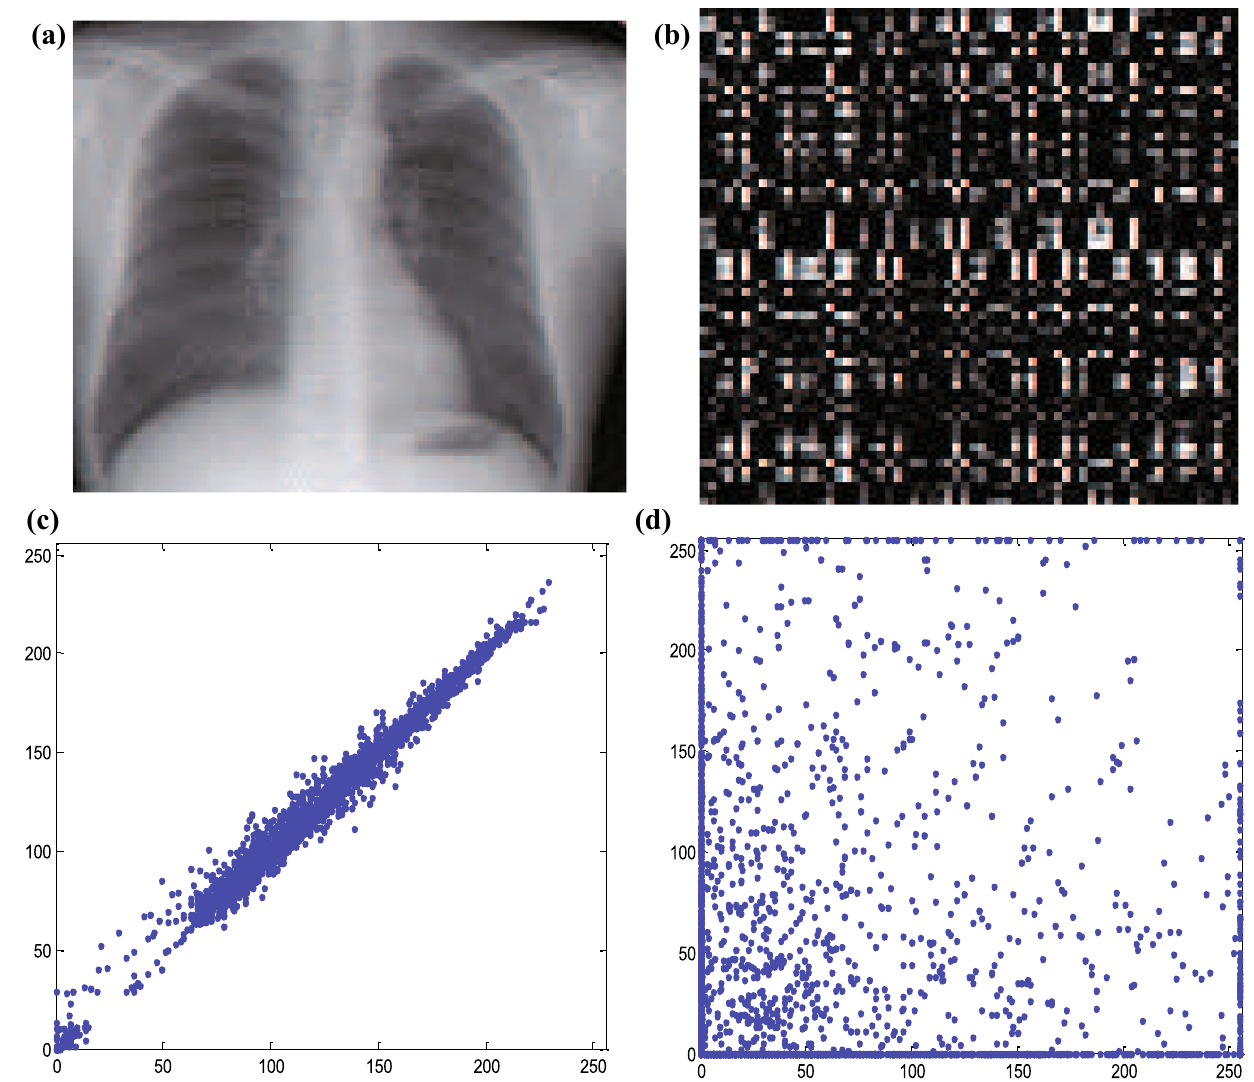
Fig. 5 Correlation analysis: ( a ) original medical image, ( b ) encrypted medical image, ( c ) the correlation of two adjacent pixels in ( a ), ( c ) the correlation of two adjacent pixels in ( b